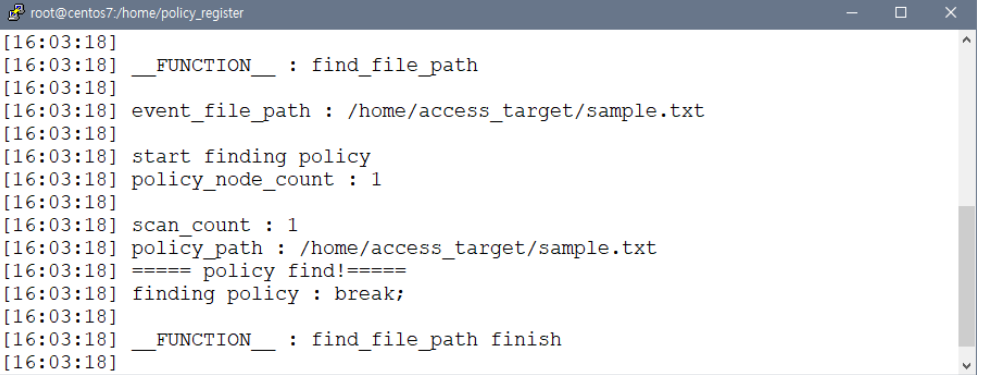
Figure 7. Monitoring policy scanning